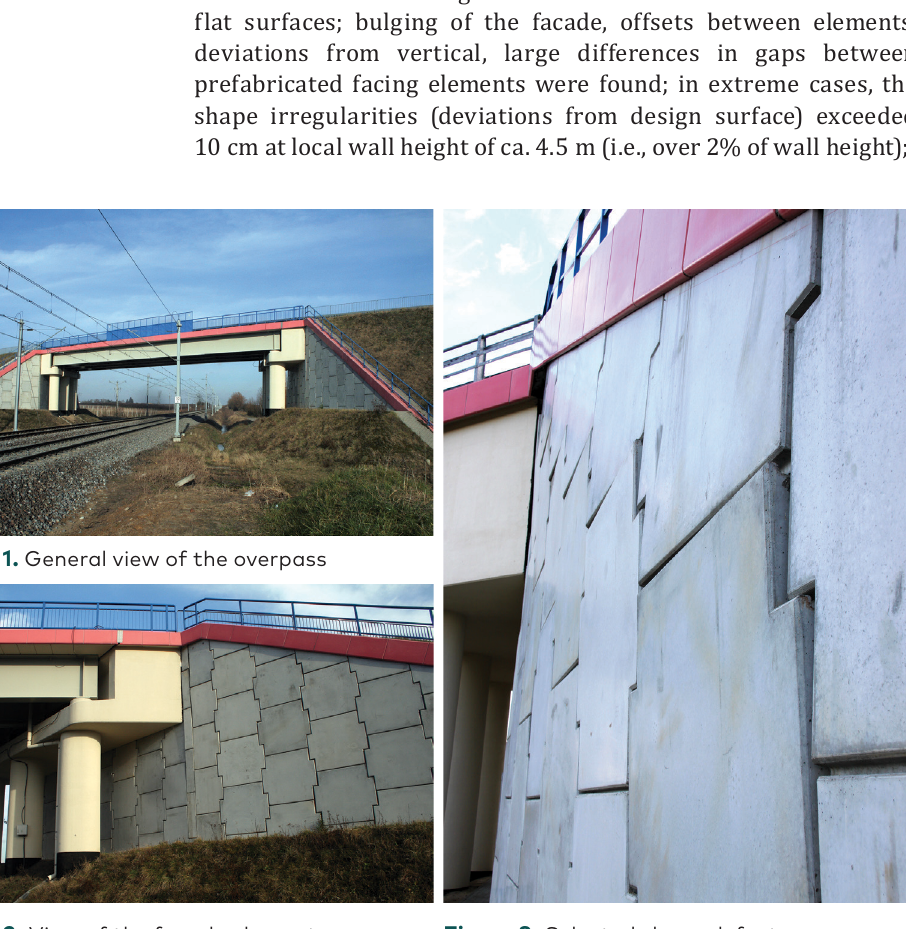
Figure 3. Selected shape defect